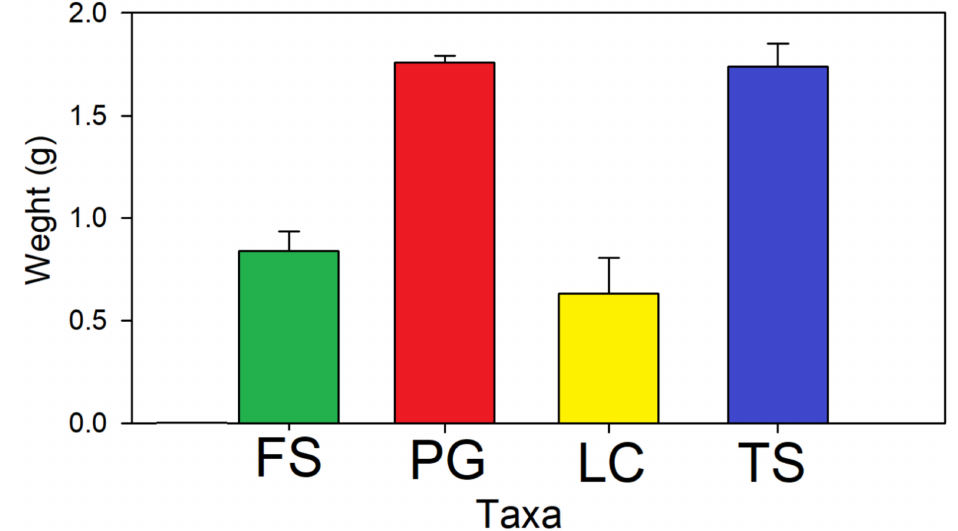
Figure 4. Mean values ( + standard deviation) of end-weights of invasive L. camara (LC; yellow) and P. guajava (PG; red) and native F. sycomorus (FS; green) and T. sericea (TS; blue). Initial weights for all species were 3.0 g of dried leaf